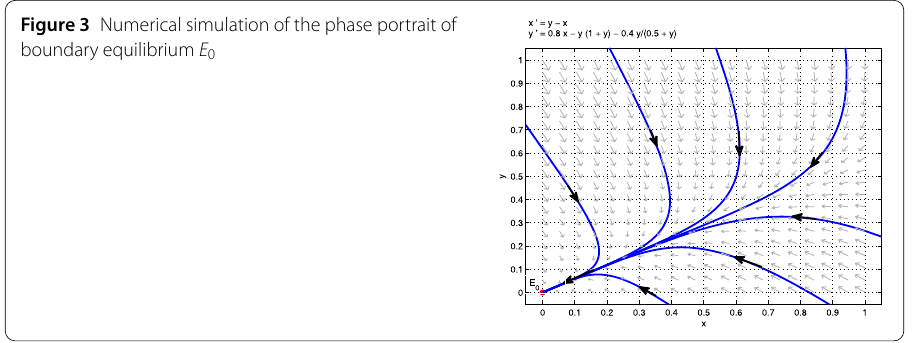
Figure 3 Numerical simulation of the phase portrait of boundary equilibrium E